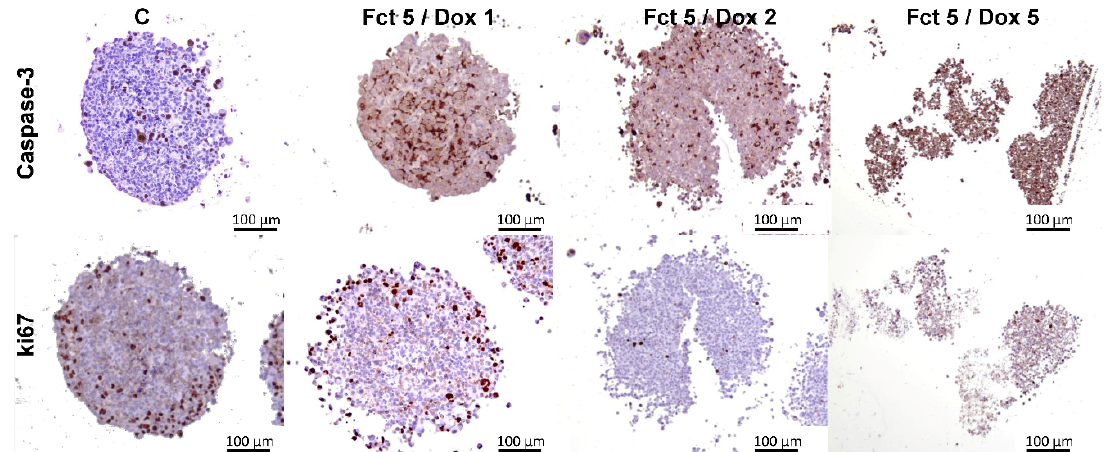
Figure 13. Representative histological images of MCAs immunostained against caspase-3 and ki67 after exposure to fucosterol (Fct) at 5 µ M in combination with doxorubicin (Dox) at 1, 2 and 5 µ M. Cells treated with 0.1% DMSO correspond to the control (C). Brown color-diaminobenzidine (DAB) indicates positive staining.